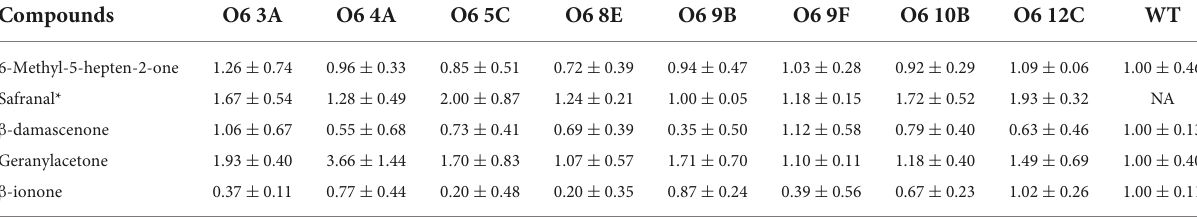
Resultsarepresentedastheratiooftransgeniclinesvs.WT.Threeplantsperlinewereanalyzed.Standarderror(SD)representsthreedeterminations.NA,notapplicable.*Thiscompound